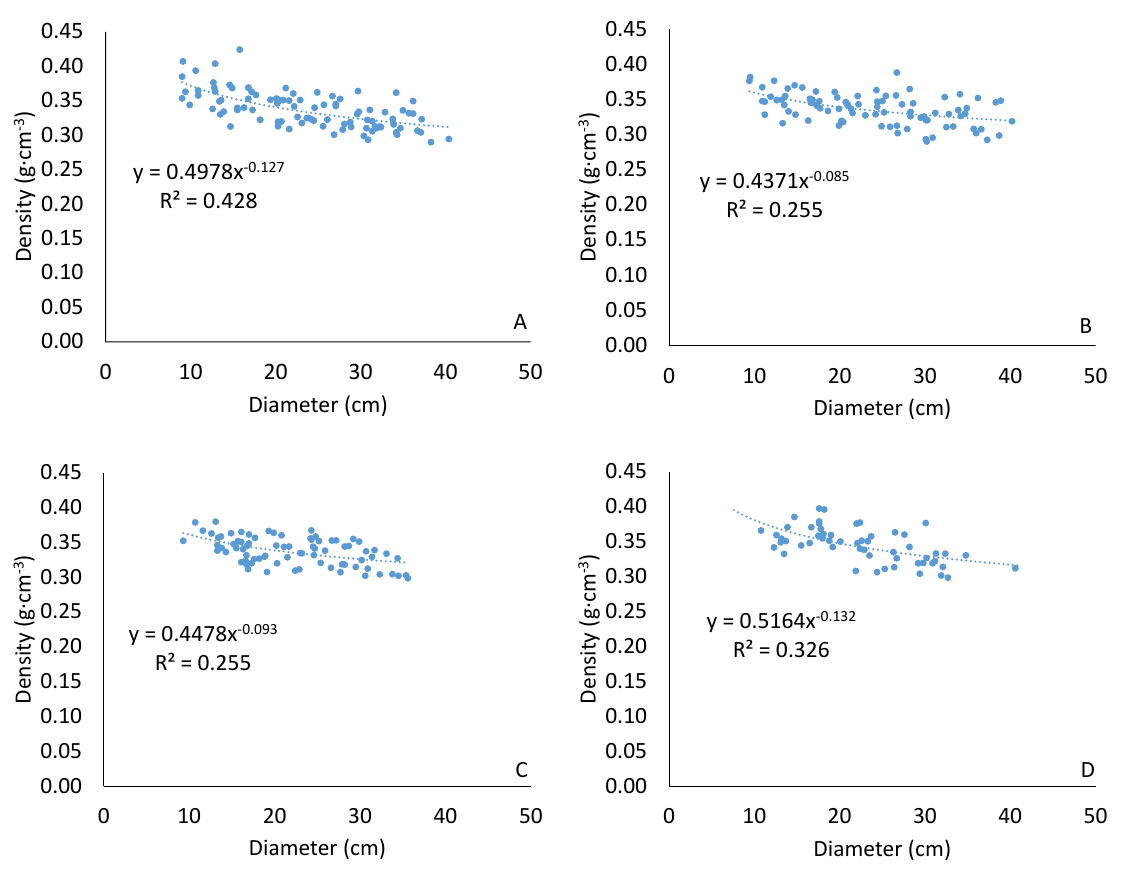
Figure 2. Relationship between diameter and wood density differentiated on plantation variants ( A ) V1, 2500; ( B ) V2, 3330; ( C ) V3, 5000; ( D ) V4, 7510 trees · ha − 1 .